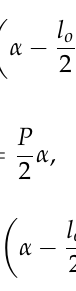
Figure 8. Plots of load against crosshead displacement for the single-lap joint specimens ( a ) for tensile–shear loading and ( b ) for three-point bending loading.